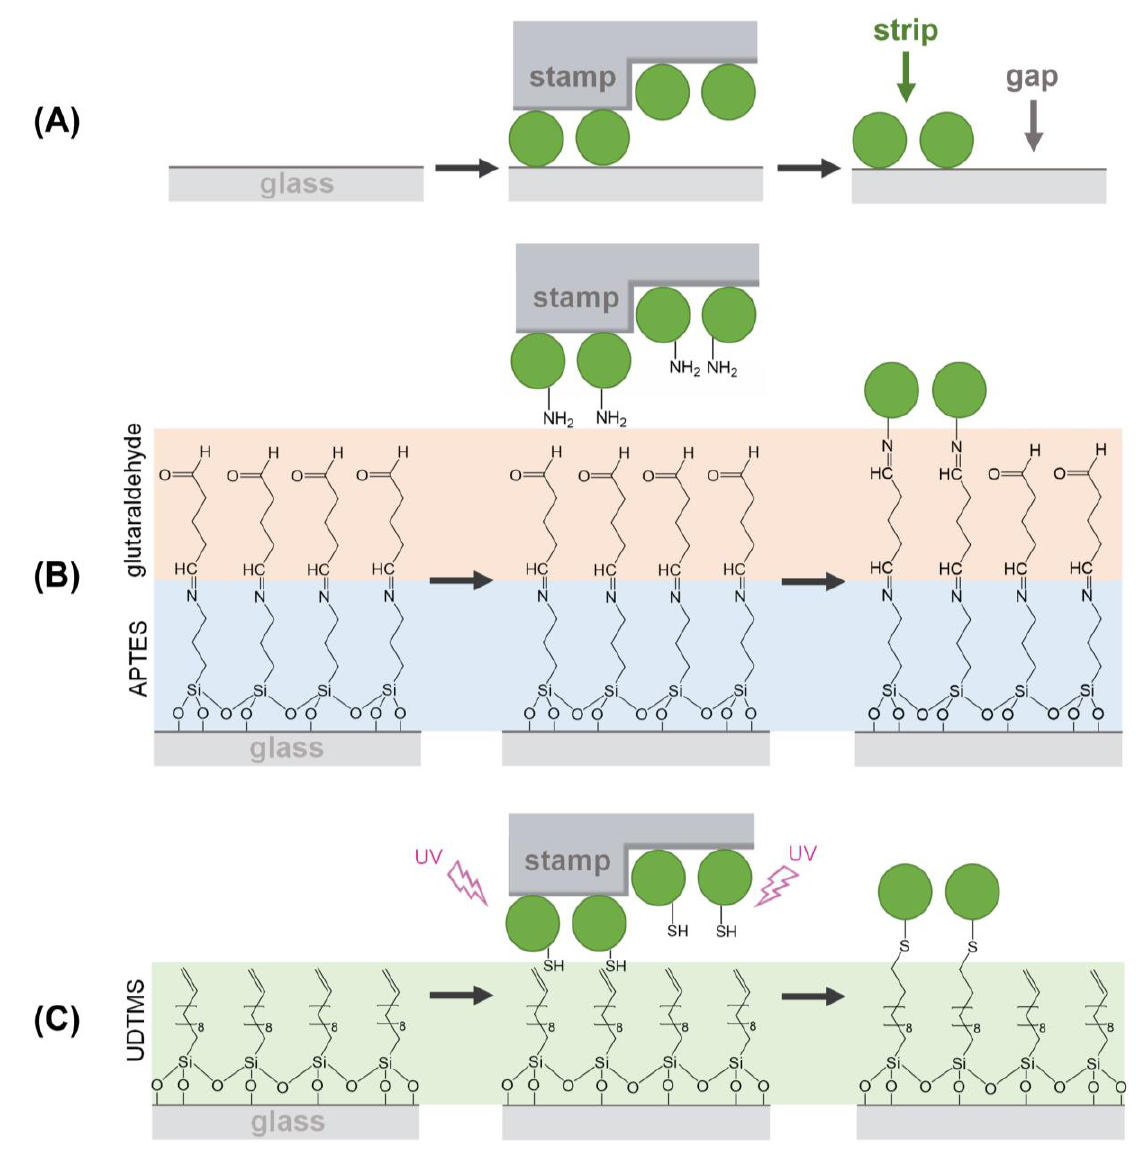
Figure 1. Schemes of the µCP routes investigated in this study for patterning proteins by combining µCP with: ( A ) physisorption, ( B ) imine coupling reaction, and ( C ) thiol-ene click